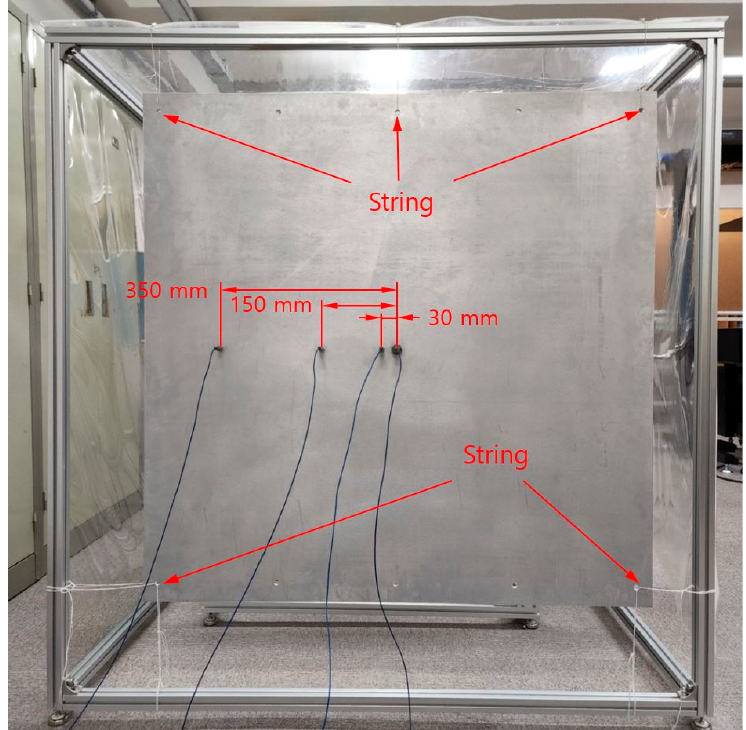
Figure 17. Shock accelerometer installation.